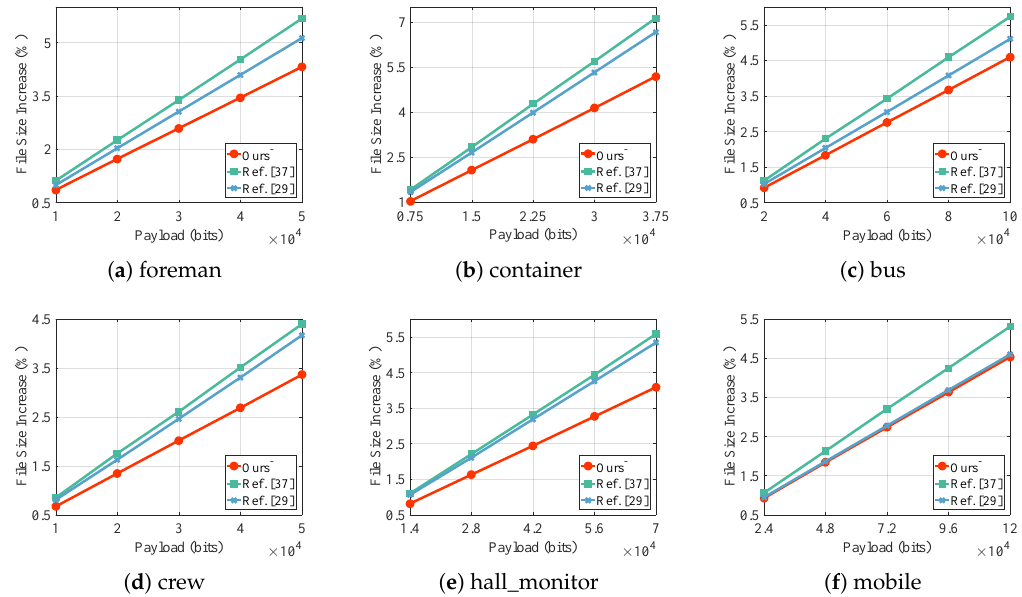
Figure 9. The increase in the file size of marked video generated by different schemes without using the ( 0,0 ) coefficient pairs when QP is 16.